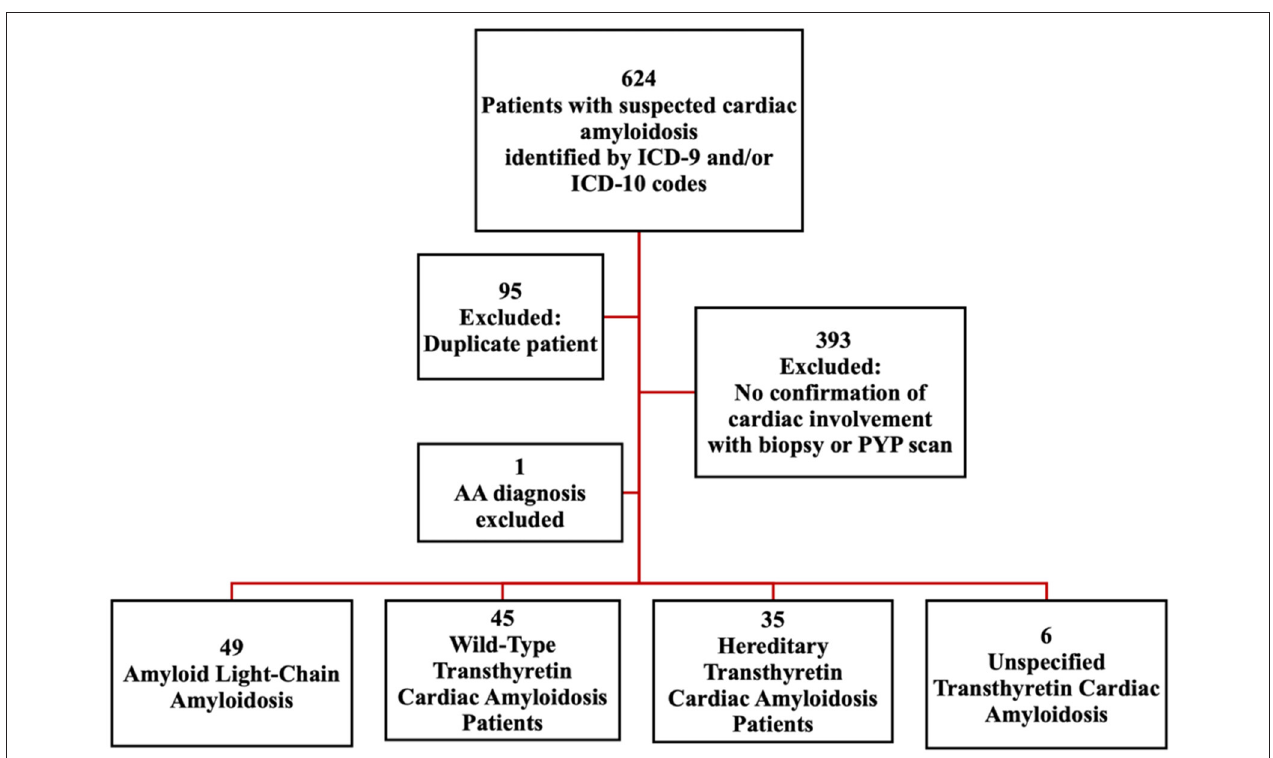
FIGURE 1 | Schematic to identify cardiac amyloidosis patients. Identification of cardiac amyloidosis patients based on ICD codes: Criterion 1, Diagnosis with wild type Wild-Type Transthyretin Amyloidosis (wtATTR), Light Chain Amyloidosis (AL) or Hereditary Transthyretin Amyloidosis (hATTR), with known cardiac involvement. OR Criterion 2, Diagnosis of heart failure (ICD-9: 428. * ; ICD-10: I50. * ) plus diagnosis of amyloidosis (ICD-9: 277.3 * ; ICD-10 E85. * ). AA, Secondary Amyloidosis; PYP scan, Technetium-99 Pyrophosphate Scintigraphy.